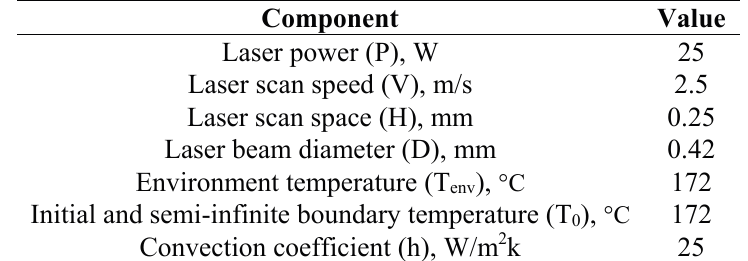
Table 2. Values of the laser properties, initial condition, and boundary